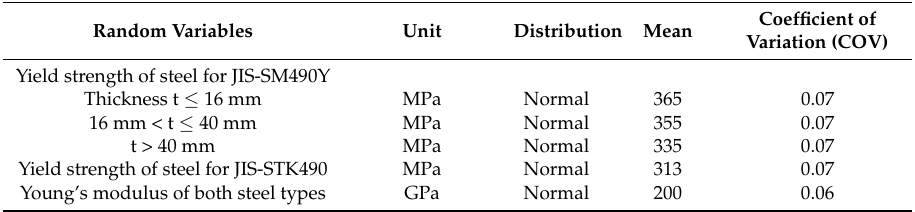
Table 1. Statistical properties of the random